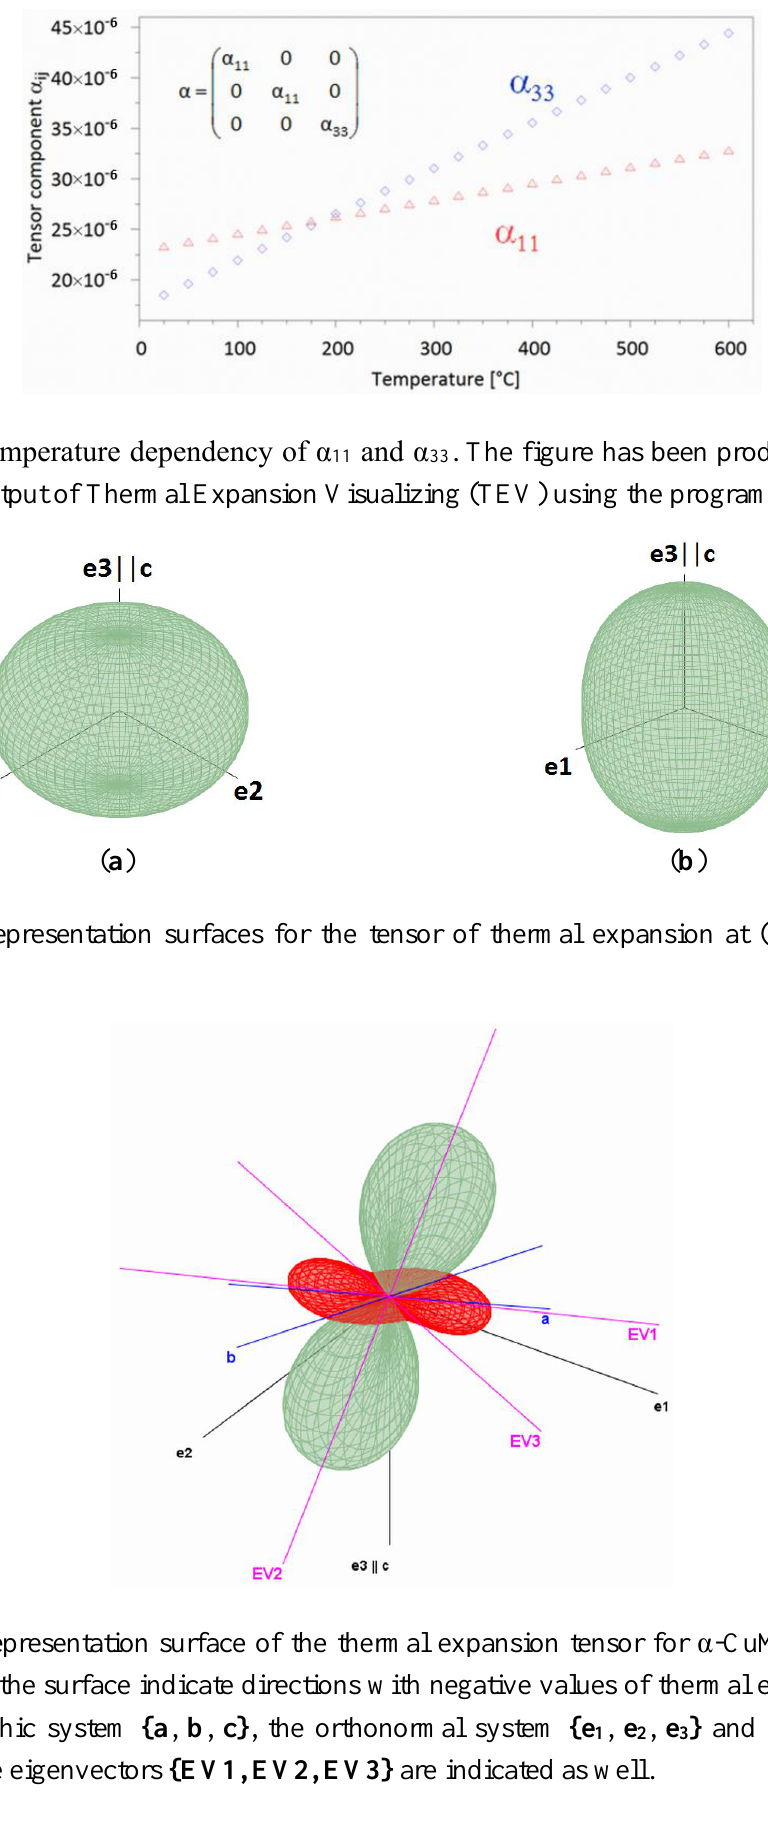
, e , e } and the coordinate 1 2 3